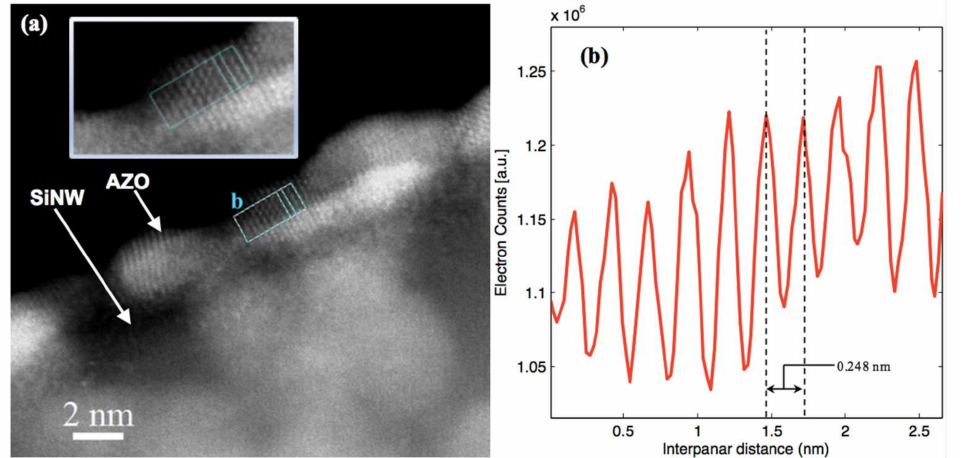
Figure 3. ( a ) High-resolution STEM image for 2 nm thick AZO layer deposited over one Si-NW. ( b ) Signal intensity profile of the AZO signal extracted from the area selected by the light blue box on a grain. The inset is a magnification of the analysed AZO crystalline